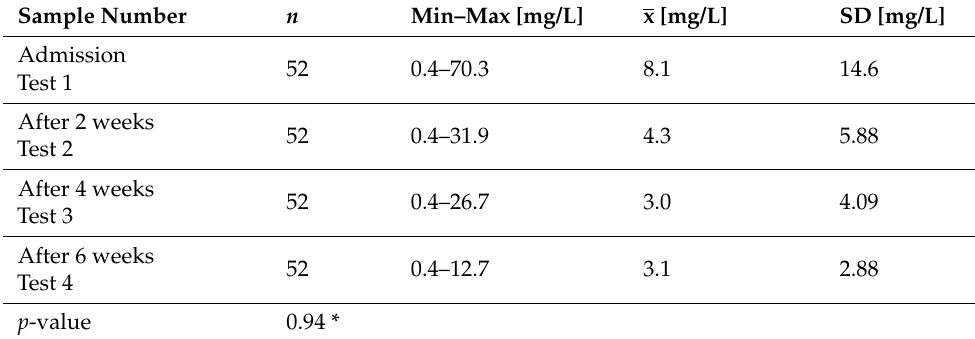
Table 2. Numerical characteristics of the results of individual CRP sampling.